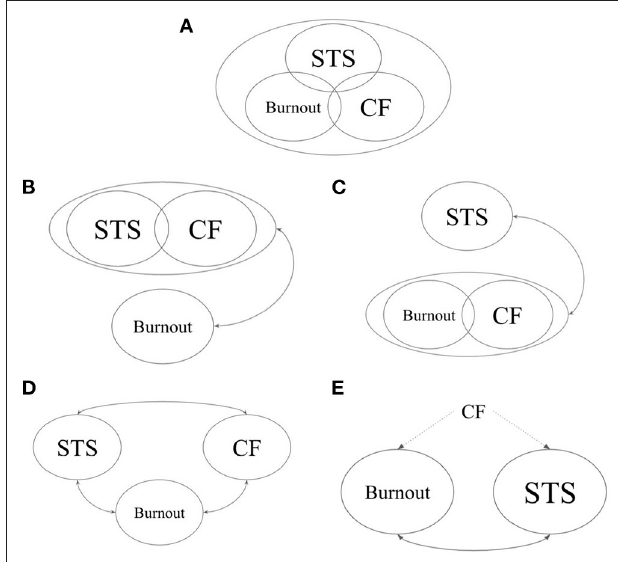
FIGURE 1 | A-priori models tested in confirmatory factor analyses. (A) Model 1: STS, CF, and burnout represent a single underlying construct ( 37). (B) Model 2: STS and CF represent a single underlying construct, while burnout represents a separate and correlated construct ( 9). (C) Model 3: Burnout and CF represent a single underlying construct, while STS represents a separate and correlated construct ( 22, 23). (D) Model 4: STS, CF, and burnout each represent a separate construct ( 38). (E) Model 5: CF describes a bifactorial construct in which burnout and STS are distinct but correlated factors (12). STS, secondary traumatic stress; CF, compassion